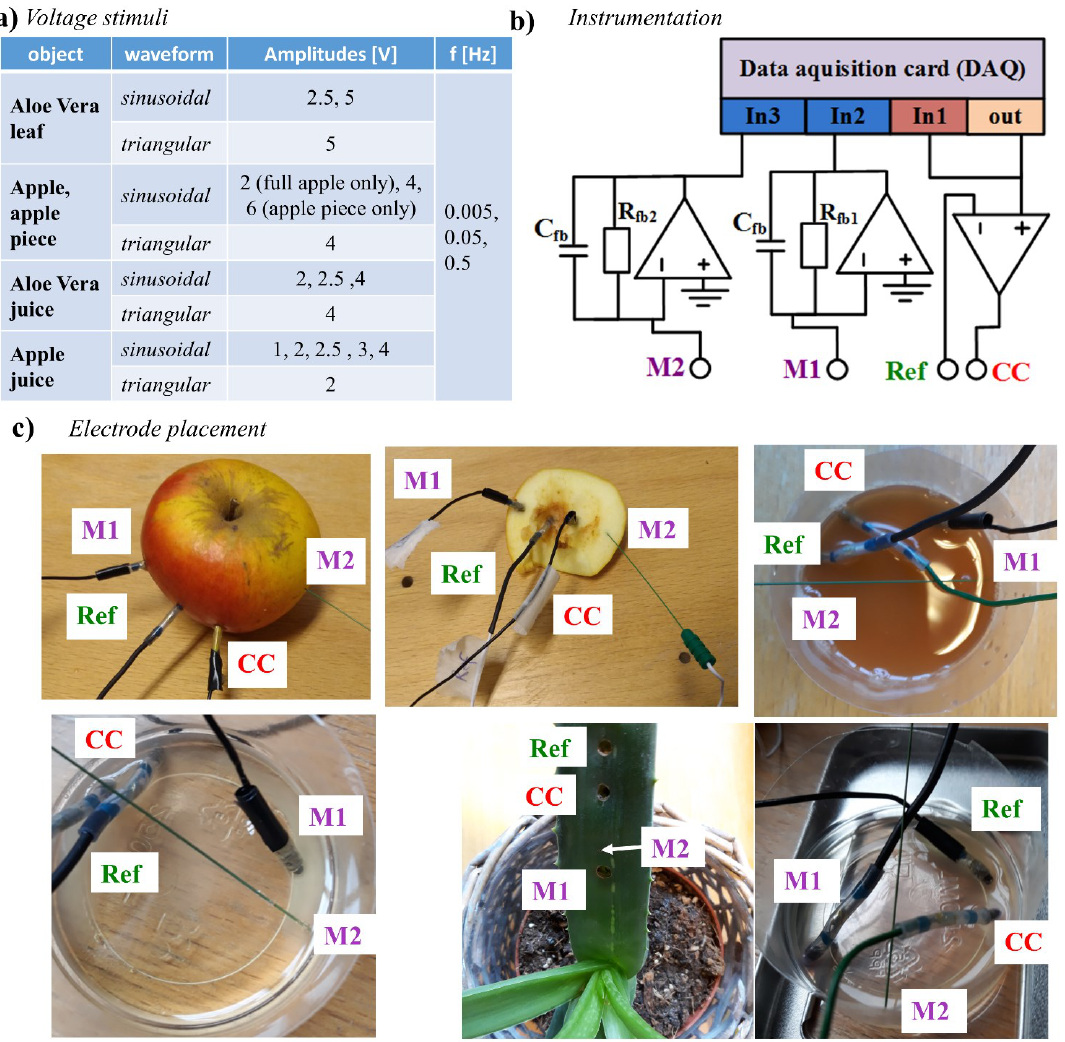
Fig 1: Methods, a) Voltage stimuli that were used in the experiment. The voltages used on the apple juice (manually obtained from one apple) are listed in the table. The measurements on the apple juice from concentrate were only done with sinusoidal voltages with amplitudes of 2.5 V and 4 V. b) Schematic of the measurement instrumentation . The recordings under the measurement electrodes M1, and M2 are monopolar and were done simultaneously, which was enabled by a three electrode setup (see [8]) with “CC” as the current carrying electrode and “Ref” as the reference electrode. c) Electrode placement on the whole apple (left), on the apple piece (middle), the apple liquid (right), apple juice from concentrate (bottom left), aloe vera leave (bottom middle) and the aloe vera liquid (bottom